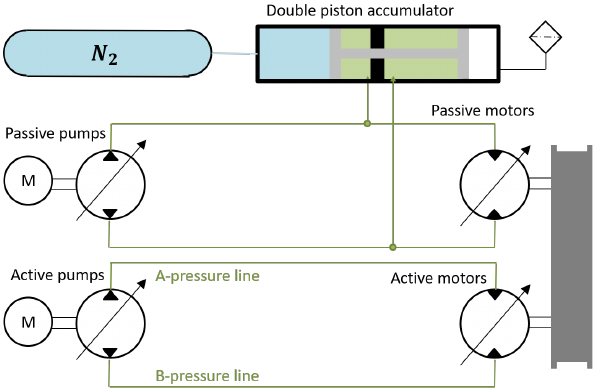
Figure 2: Simplified schematics of an active/passive hydraulic active heave compensated